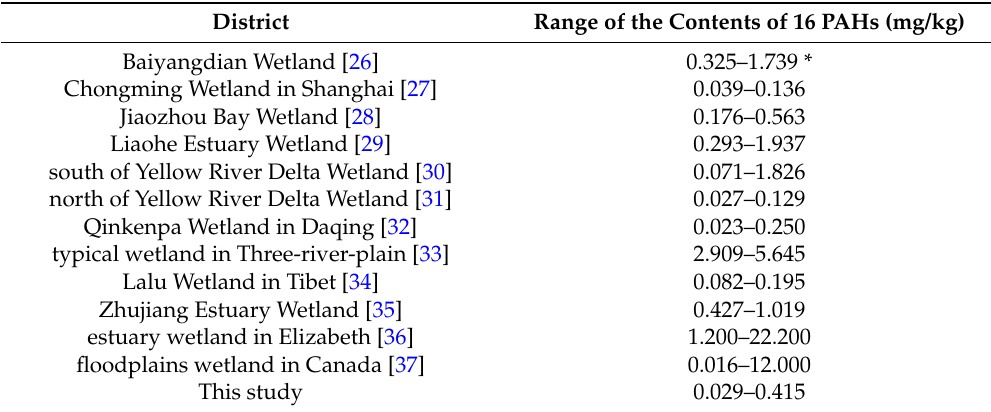
Table 2. The PAH content in wetlands at home and abroad.